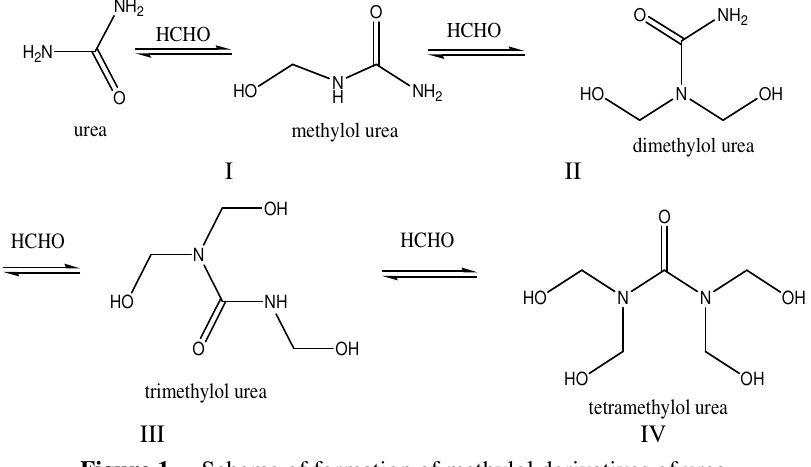
Figure 1. Scheme of formation of methylol derivatives of